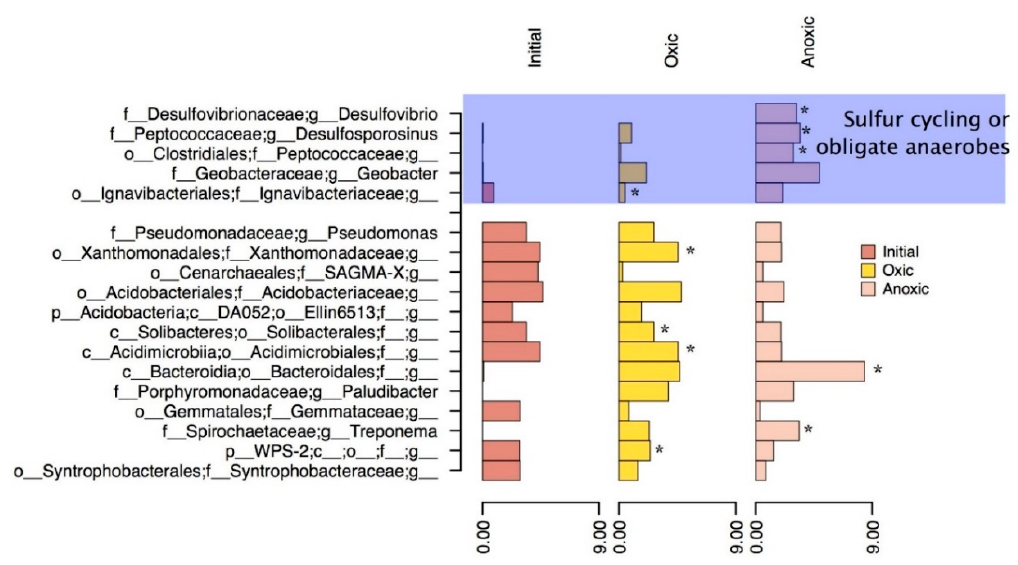
Figure 6. Most abundant Genera in the final oxic and anoxic timepoints, as well as the initial in situ bacteria. The asterisks represent genera that have significant differential abundant OTUs between the oxic and anoxic communities. The top blue section of the figure are Genera that have shown to be important for sulfur cycling or other obligate anaerobic pathways based on literature searches.